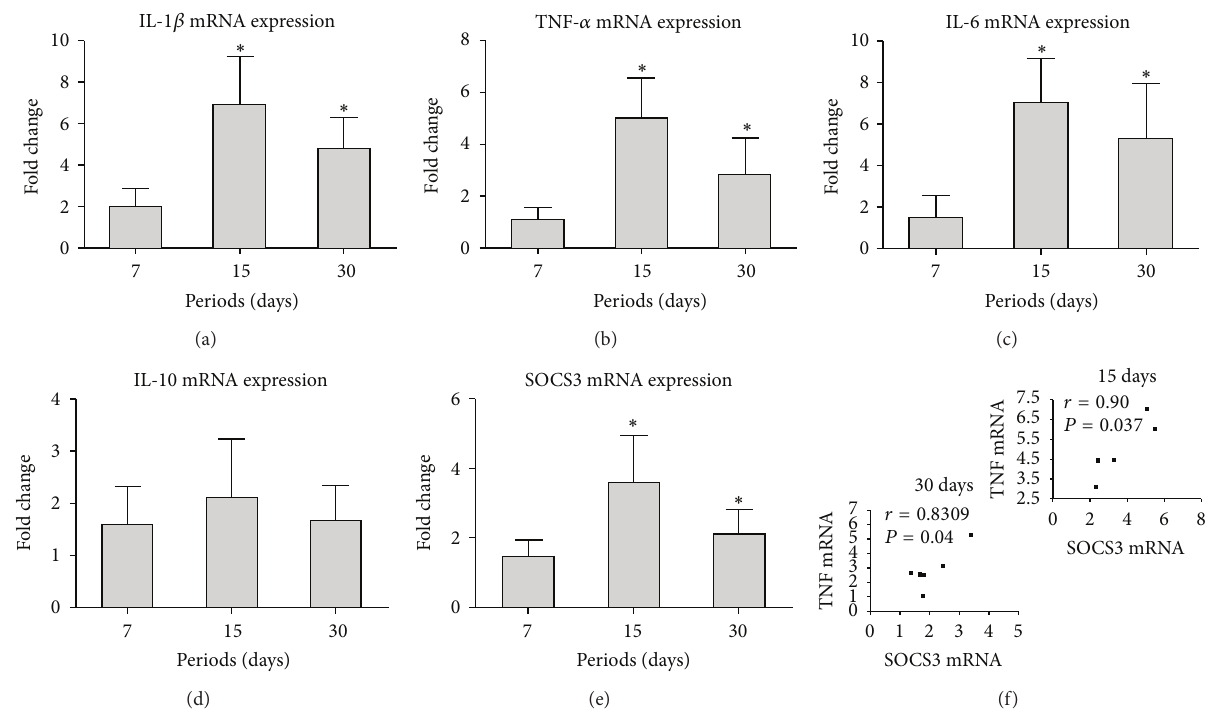
Figure 2: Profile of the gene expression of SOCS3, proinflammatory cytokines IL-1 𝛽 , TNF- 𝛼 , and IL-6 and anti-inflammatory cytokine IL-10 during the course of LPS-induced periodontal disease. Expression of all proinflammatory cytokines and SOCS3 was increased at the 15- and 30-day experimental periods, with a peak in this increase at 15 days. No regulation of the anti-inflammatory cytokine IL-10 was observed in any of the experimental periods. mRNA expression was normalized to the expression of the housekeeping gene GAPDH. The bars represent mean fold changes, and the vertical lines represent the standard deviation of the mean fold change of six animals in each experimental group in comparison to untreated control. ∗ Significant differences ( 𝑃 < 0.05 , ANOVA, and post hoc Tukey tests for pairwise